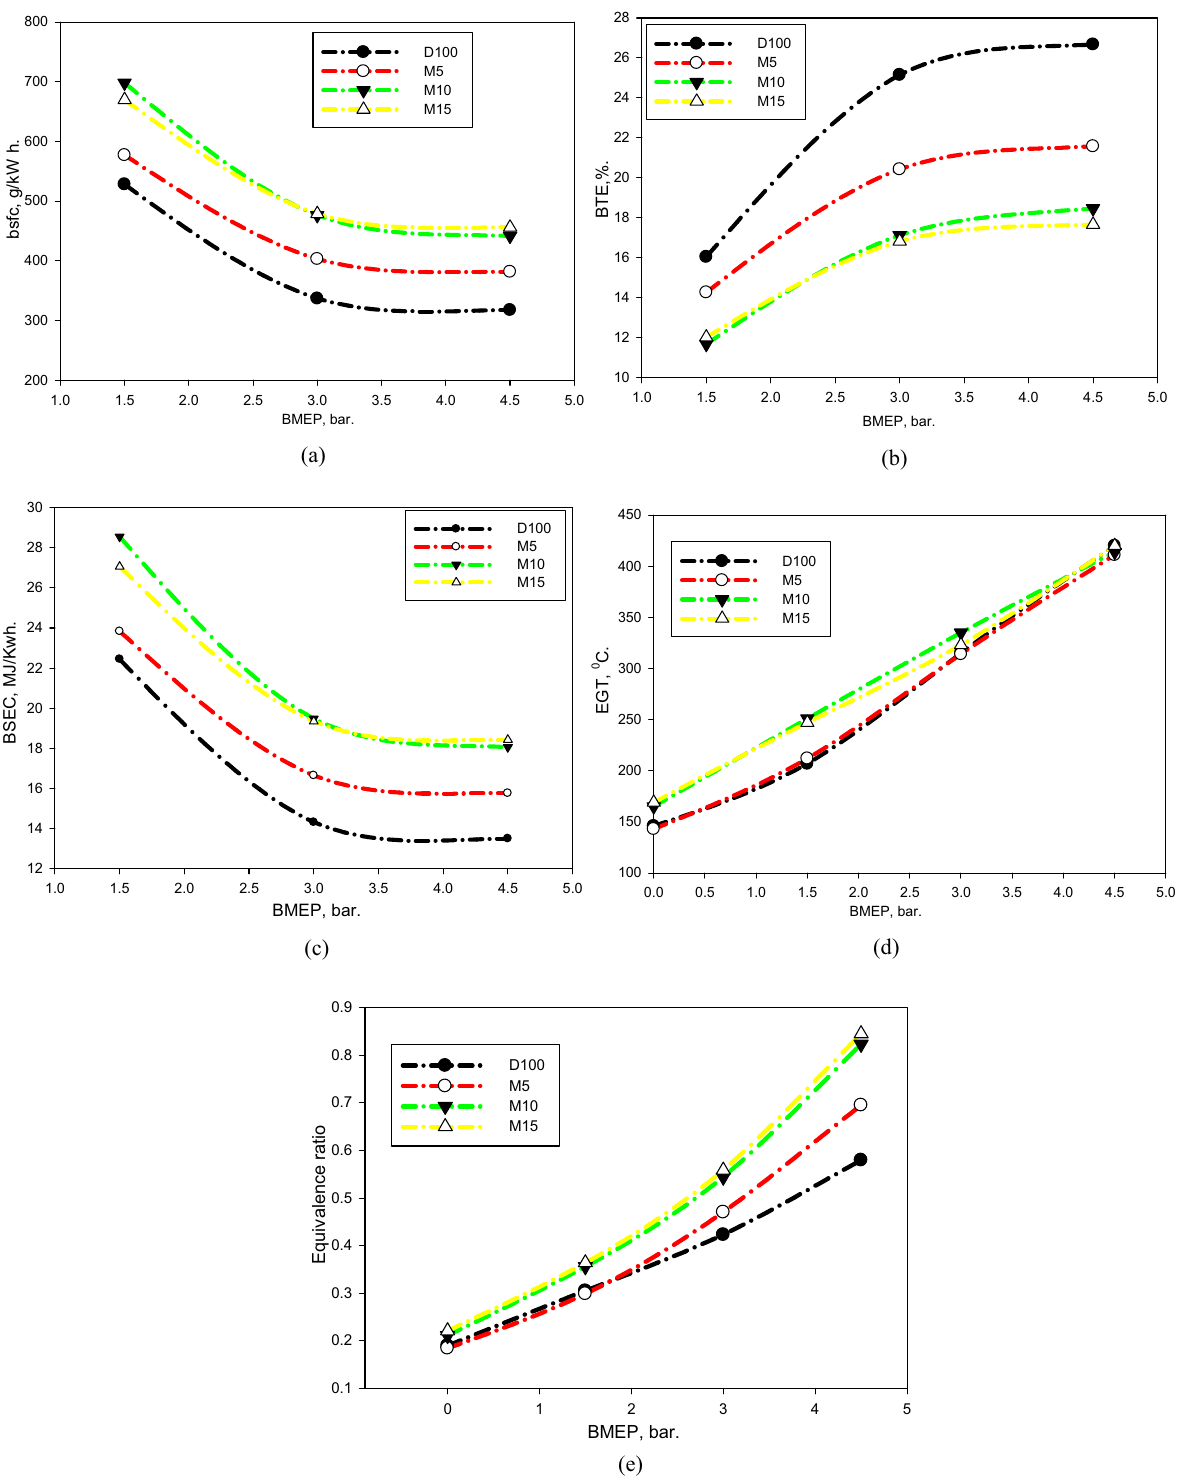
Figure 8. ( a ) BSFC, ( b ) BTE, ( c ) BSEC, ( d ) EGT, and ( e ) equivalence ratio of assessed fuels at different